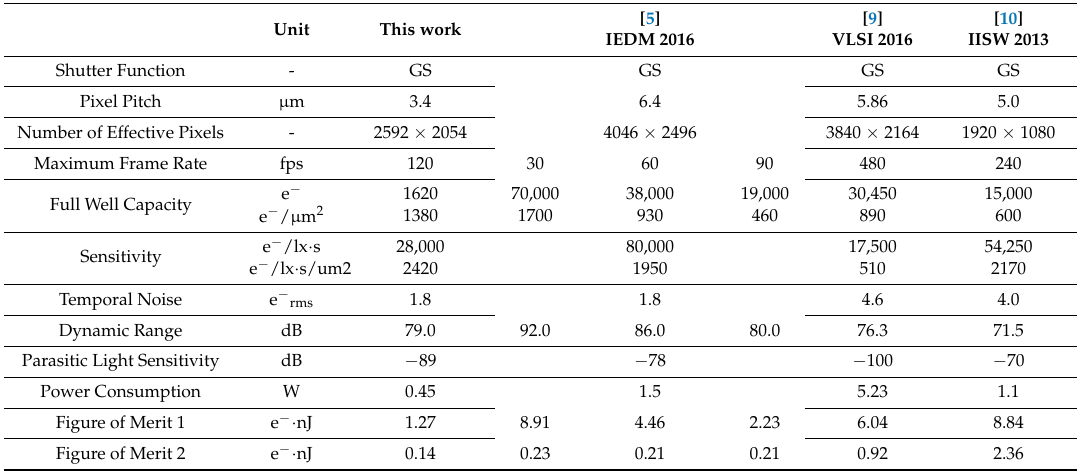
Table 2. Summarized specifications and characteristics